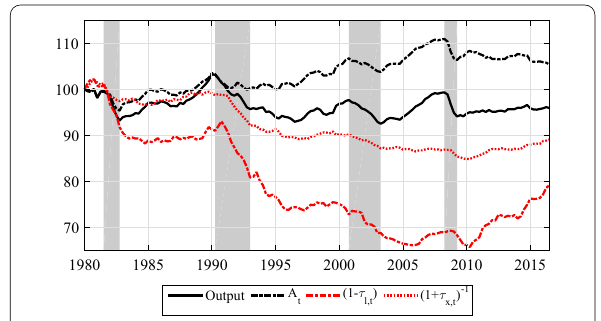
Fig. 11 Robustness: Output and wedges for ν = 2 (1980Q1–2016Q3). A